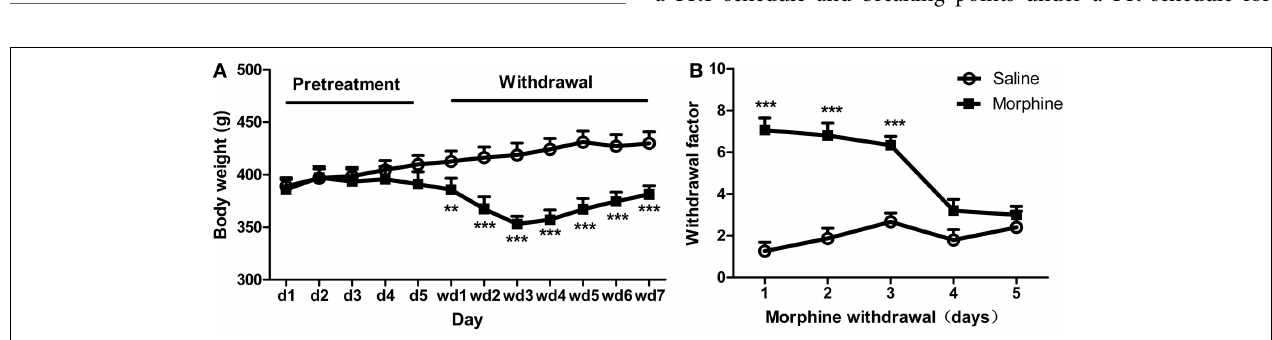
FIGURE 2 | Other physical and behavioral signs after morphine exposure. (A) Body weights of the rats throughout the pretreatment and withdrawal. (B) Withdrawal scores in rats